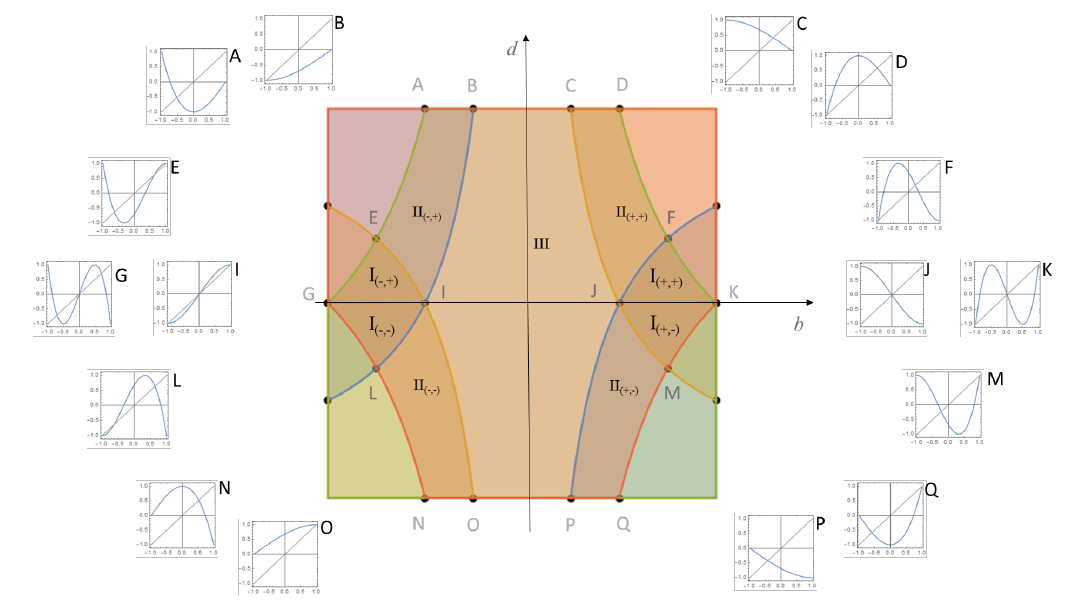
Figure 1. Space of parameters ( b , d ) with the dynamical behavior